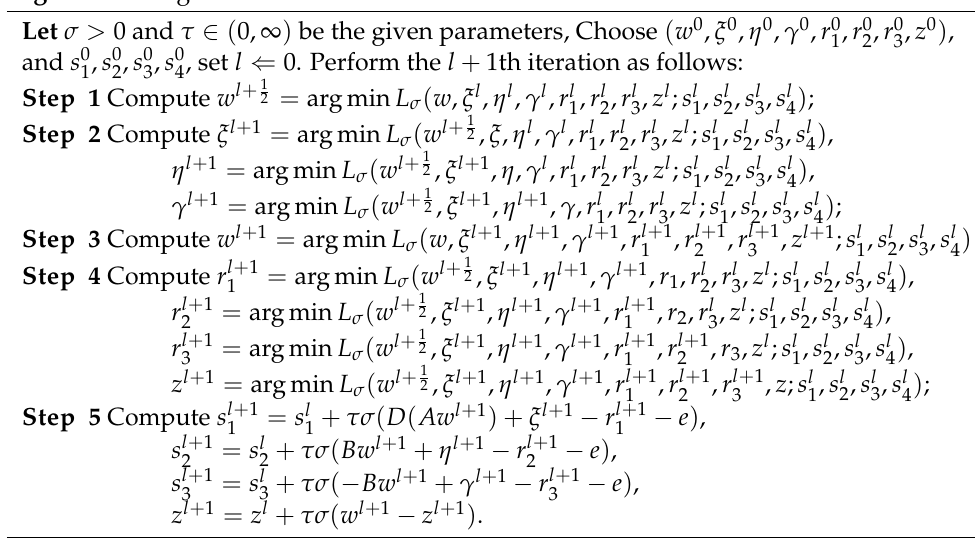
Algorithm 2 Algorithm